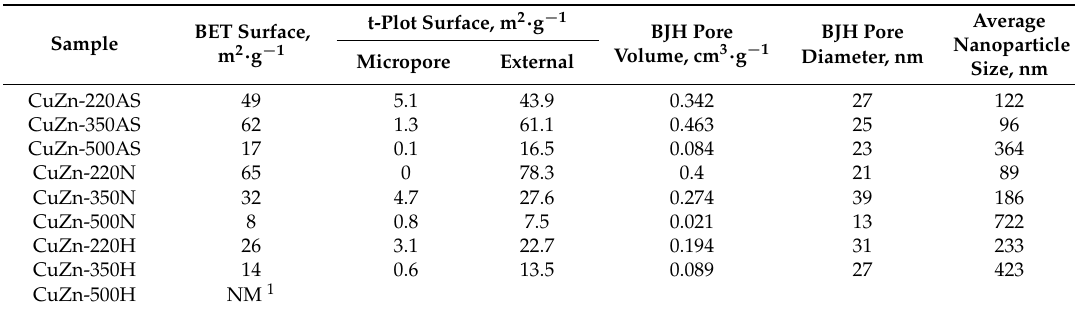
Table 2. The textural properties of the CuZn catalysts prepared by the calcination of the CuZn precursor in air, nitrogen, and hydrogen at 220, 350, and 500 °C.